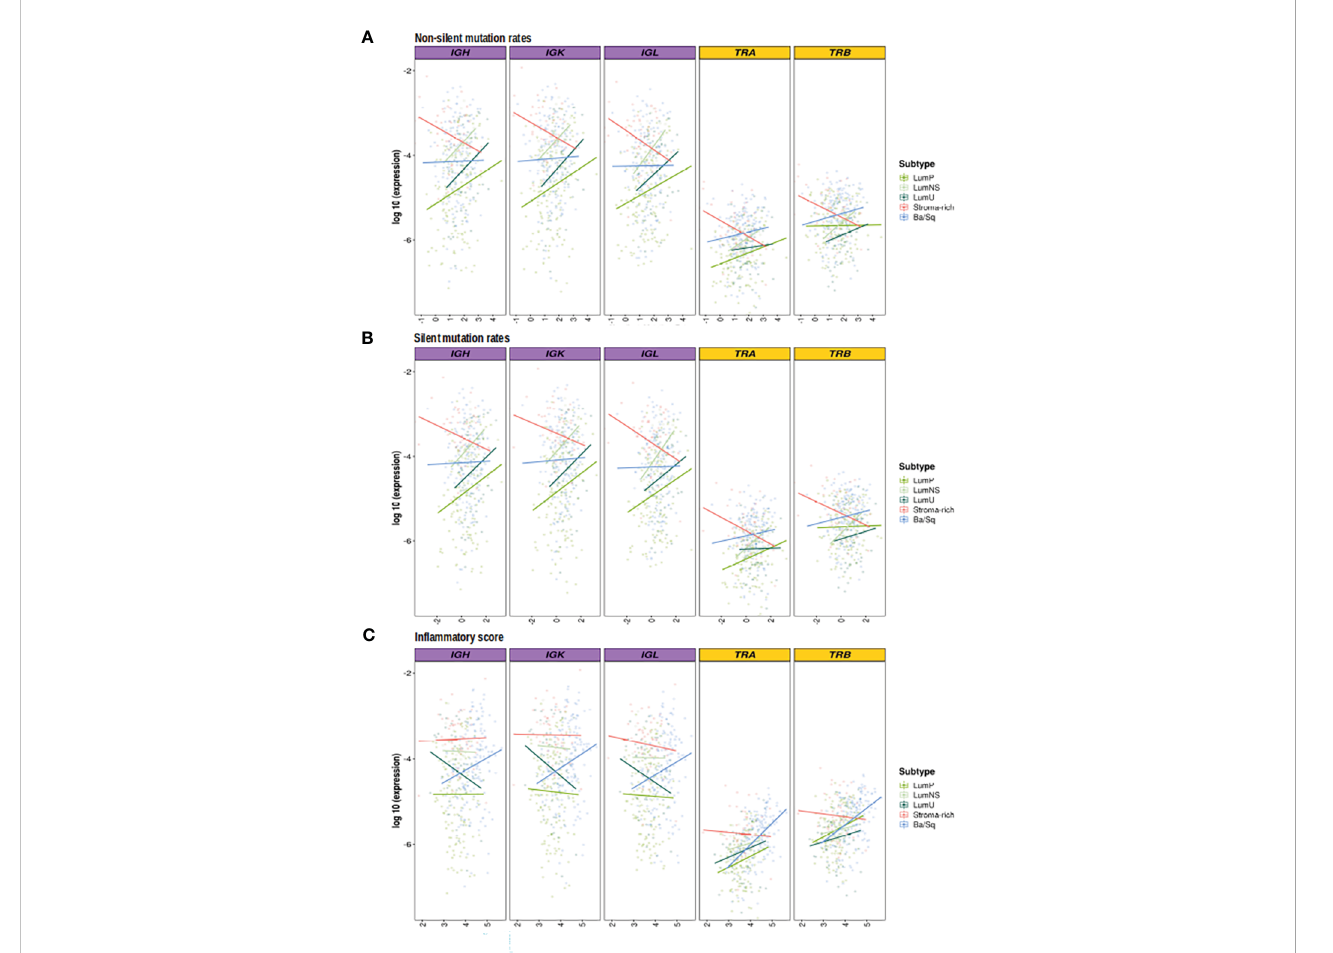
FIGURE 4 Correlation between mutational rates and in fl ammatory score with richness by subtypes. BCR related results are plotted in purple and TCR in yellow. In the Y axis the logarithm of the expression is displayed. On the X axes, the logarithm 10 of the (A) non-silent (B) silent mutational rates, (C) in fl ammation score are plotted. Each line, is the regression line assessed in the correlation test performed by subtypes and they are colored by them.